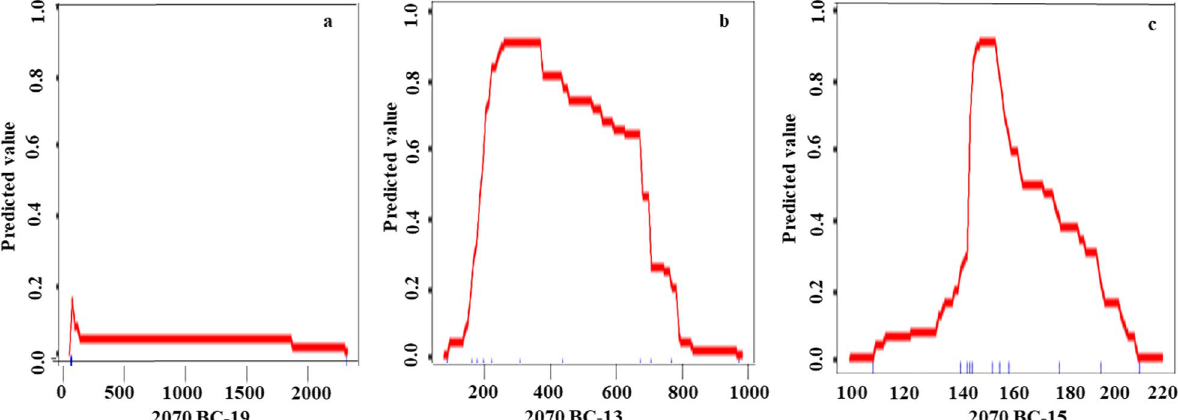
Fig. 6 Receiver operating characteristics curve (ROC) illustrating relationship between probability of occurrence of suitable conditions for distribution of C. wightii with most significant bioclimatic predictor during 2070 time frame: a PrCQ, b PrWeM and c